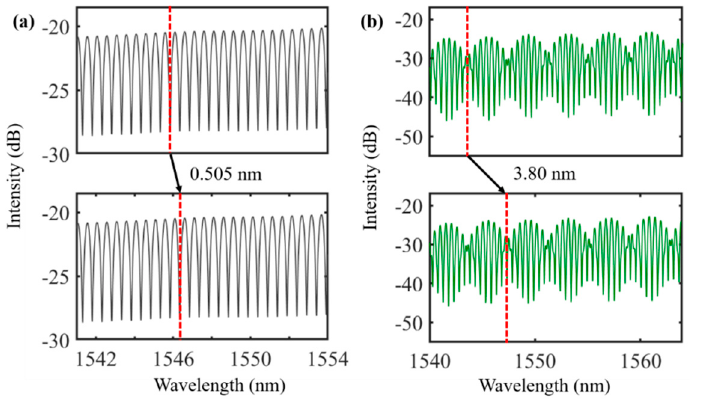
Figure 6. Wavelength shift of ( a ) MXene-MKR and ( b ) the cascade system at a pump power of 34 mW.